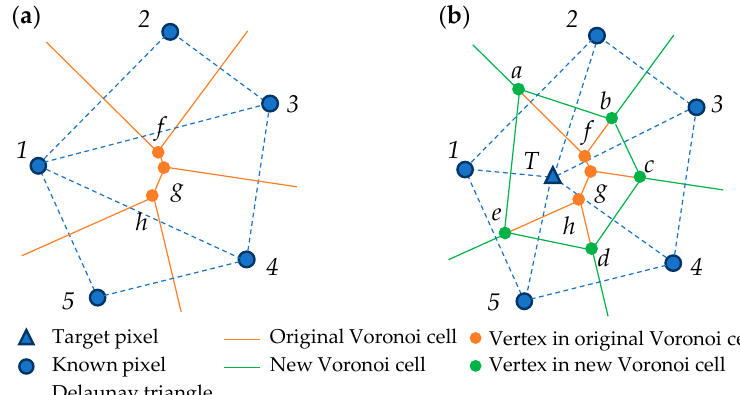
Figure 6. Voronoi diagrams for weight calculation. ( a ) Voronoi diagram of known neighboring pixels. ( b ) New Voronoi diagram of the neighboring pixels and target pixel.